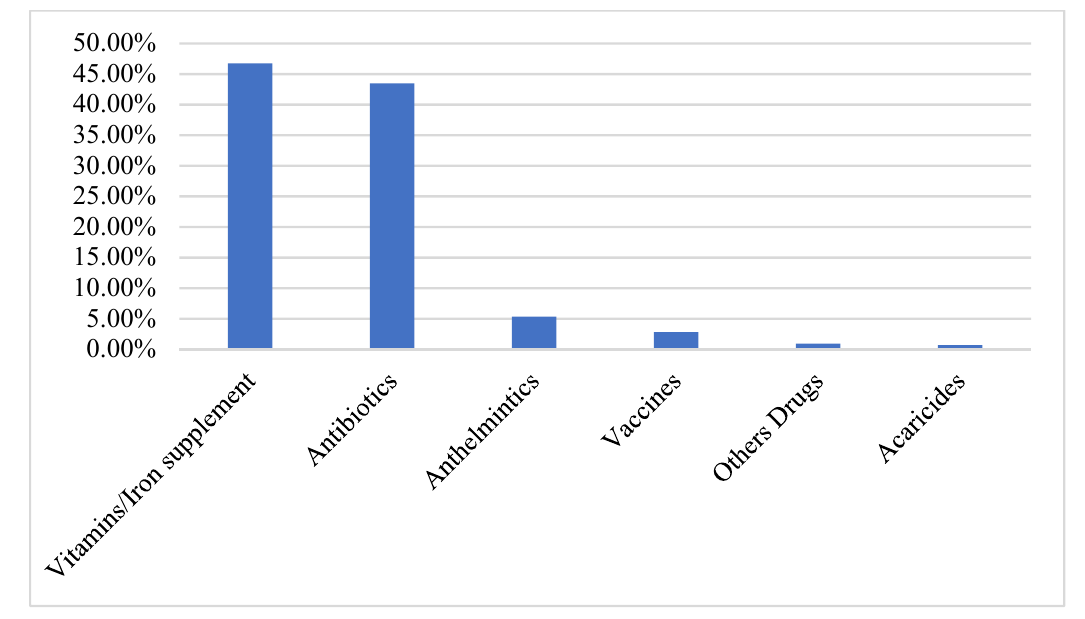
Figure 1. Types of veterinary drugs used in chicken farms.